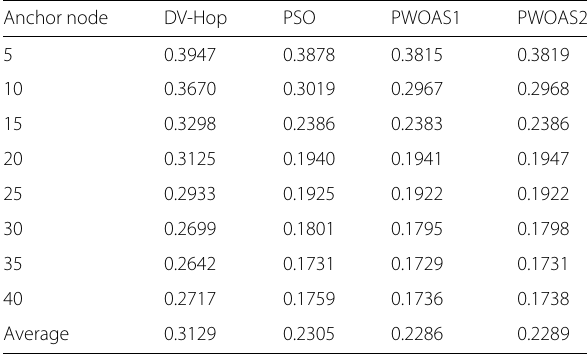
Table 4 The localization error of varying anchor node amount shows the experimental results of varying node amount Anchor